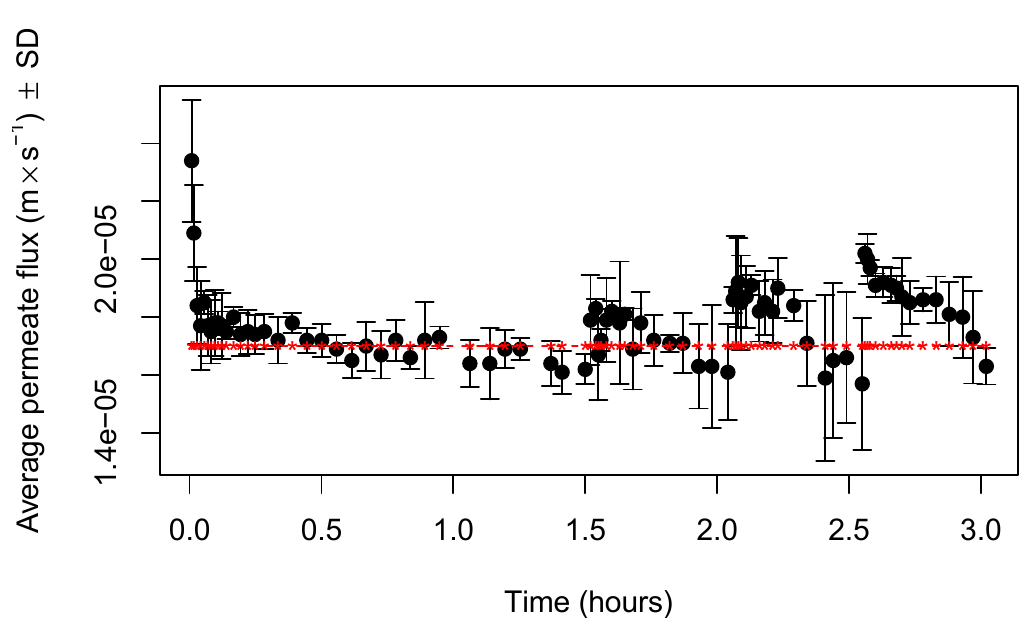
Figure 2. Variation of average permeate fluxes ( ± standard deviation) with time, during the process of UF/DF, obtained with membranes RC70PP (n = 3 experiments), at a transmembrane pressure of 0.2 MPa.